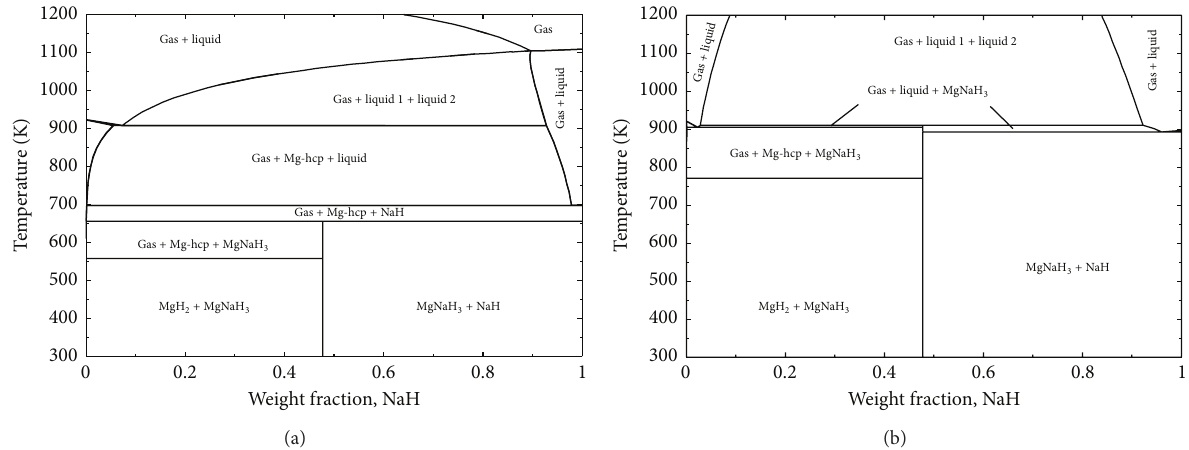
Figure 13: Calculated vertical section of Mg-Na-H system along the composition line MgH 2 -NaH at (a) 1 bar and (b) 100 bar.